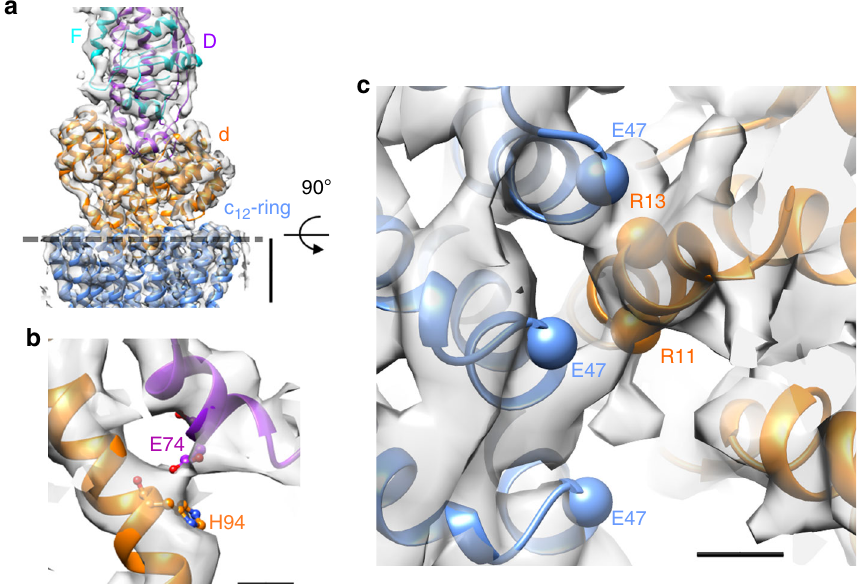
Fig. 4 Structure of the central rotor. a A model of the center of the rotor complex. The d-, D, F, and c-subunits are colored in orange, purple, cyan, and blue, respectively. The experimental map is shown in semi-transparent gray. Scale bar, 20 Å. b A magni fi ed view of the boundary surface of the central rotor between V 1 -DF and V o -d. Residues of E74 on the D-subunit and H94 on the d-subunit are ball and sticks format. Scale bar, = 5 Å. c A magni fi ed view of the boundary surface of the d-subunit and inner helices of the c-subunits. Residues of E47 on the c-subunits and R11 and R13 on the d-subunit are depicted in sphere formats. Scale bar, = 5